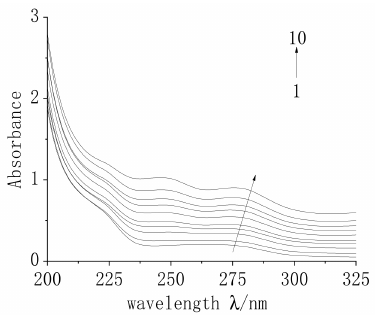
Figure 7. Ultraviolet spectra of MC and TRP. C (TRP) = 1 × 10 − 4 mol/L; C (MC) = (1–10) 0, 0.5, 1, 1.5, 2, 2.5, 3, 3.5, 4, 4.5 × 10 − 5 mol/L; pH = 7.4; T = 298